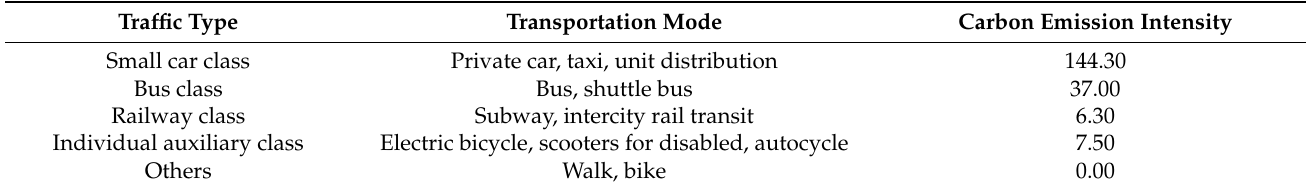
Table 3. CO 2 emission intensity by transport modes